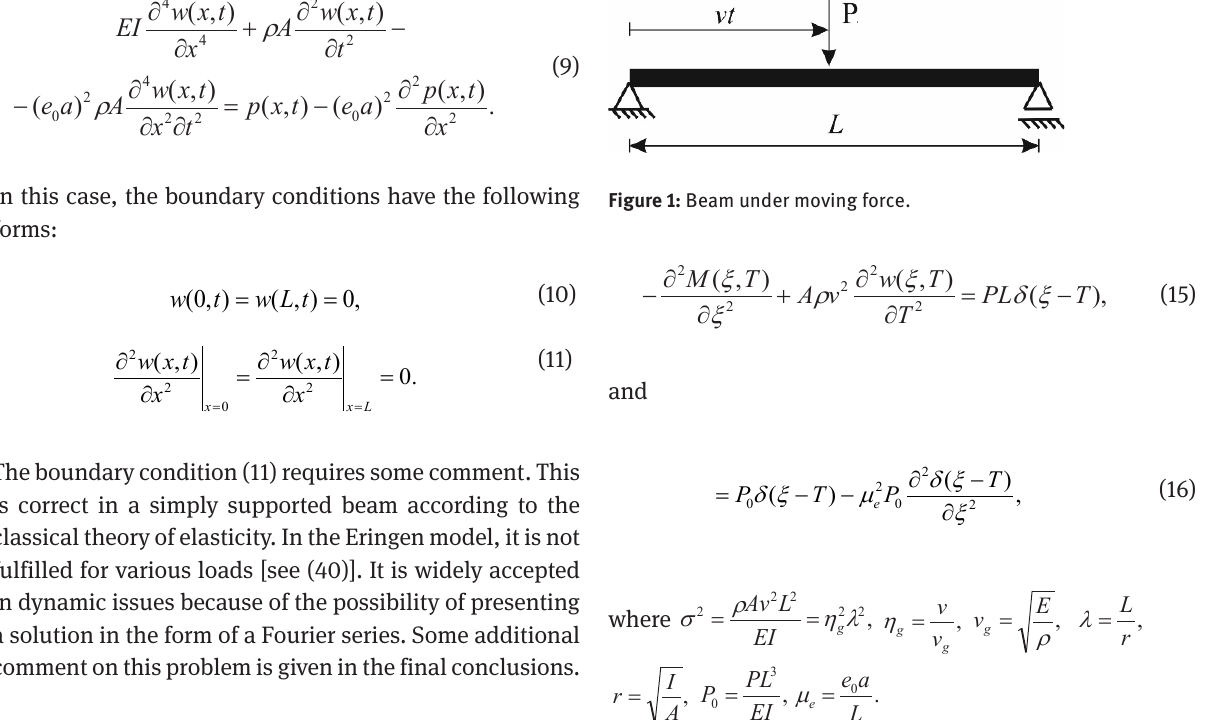
Fig. 1 Beam under moving force